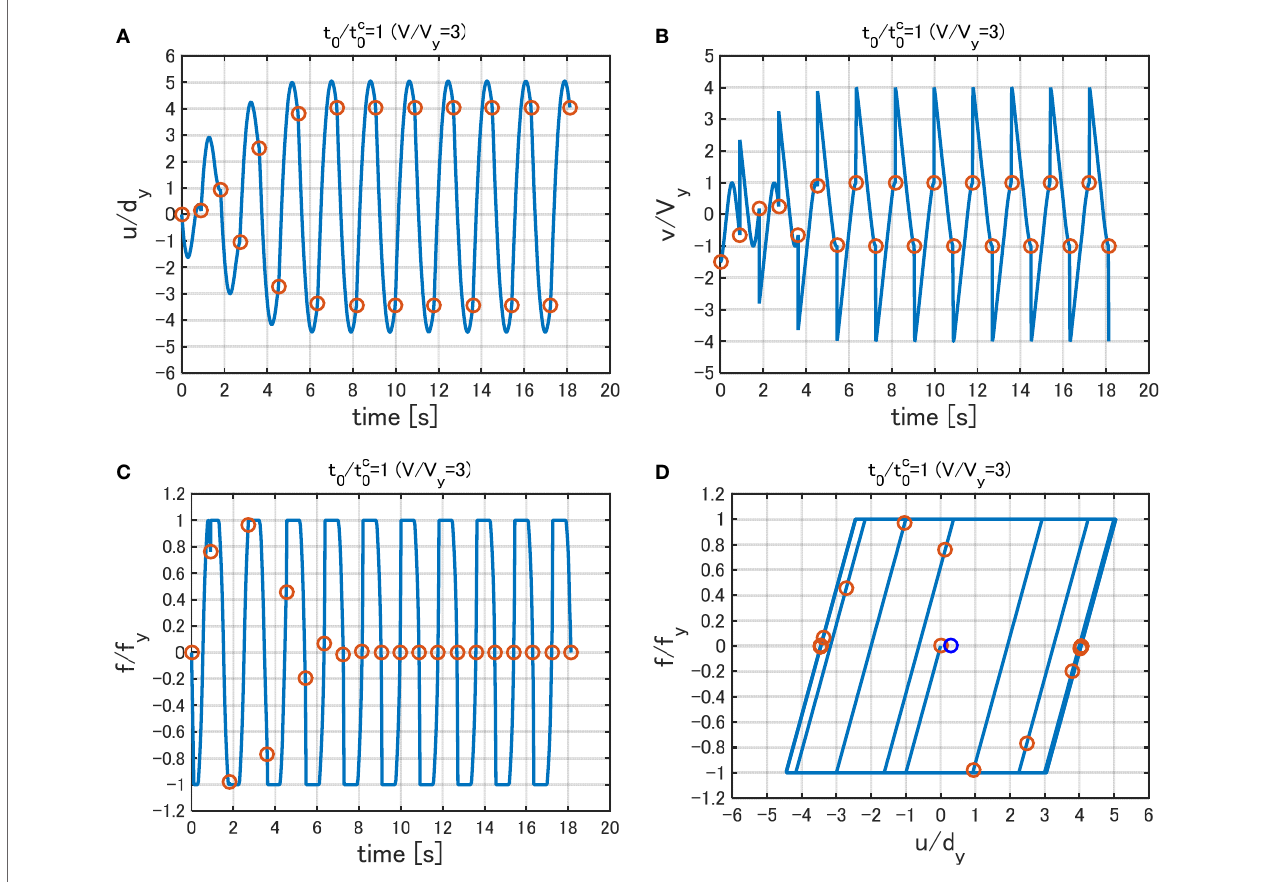
FigUre 8 | response to input sequence 1 for V / V y = 3 (impulse timing is the critical one obtained by using the input sequence 2): (a) displacement, (B) velocity, (c) restoring force, and (D) force–deformation relation